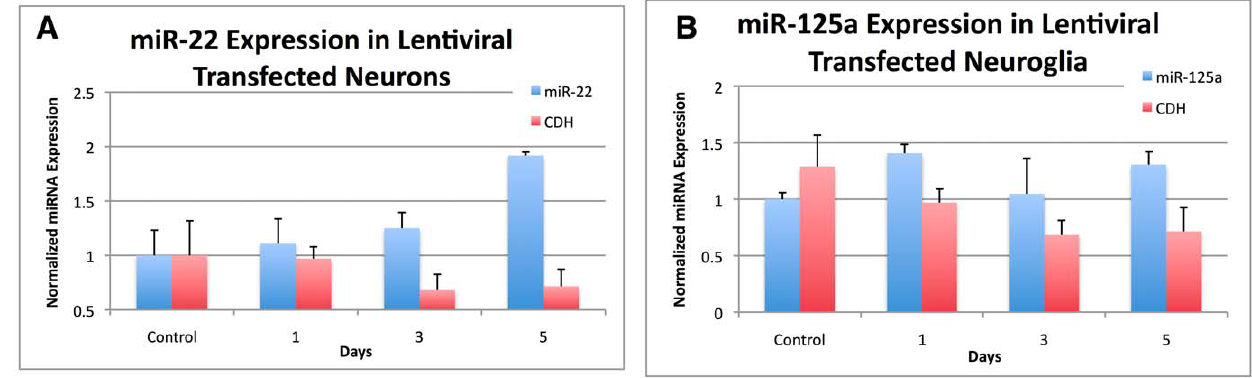
Figure 5. Lentiviral overexpression of (A) miR-22 and (B) miR-125a in primary neuronal cultures.